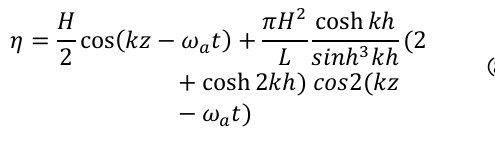
Figure 2. University of Liverpool recirculating water channel